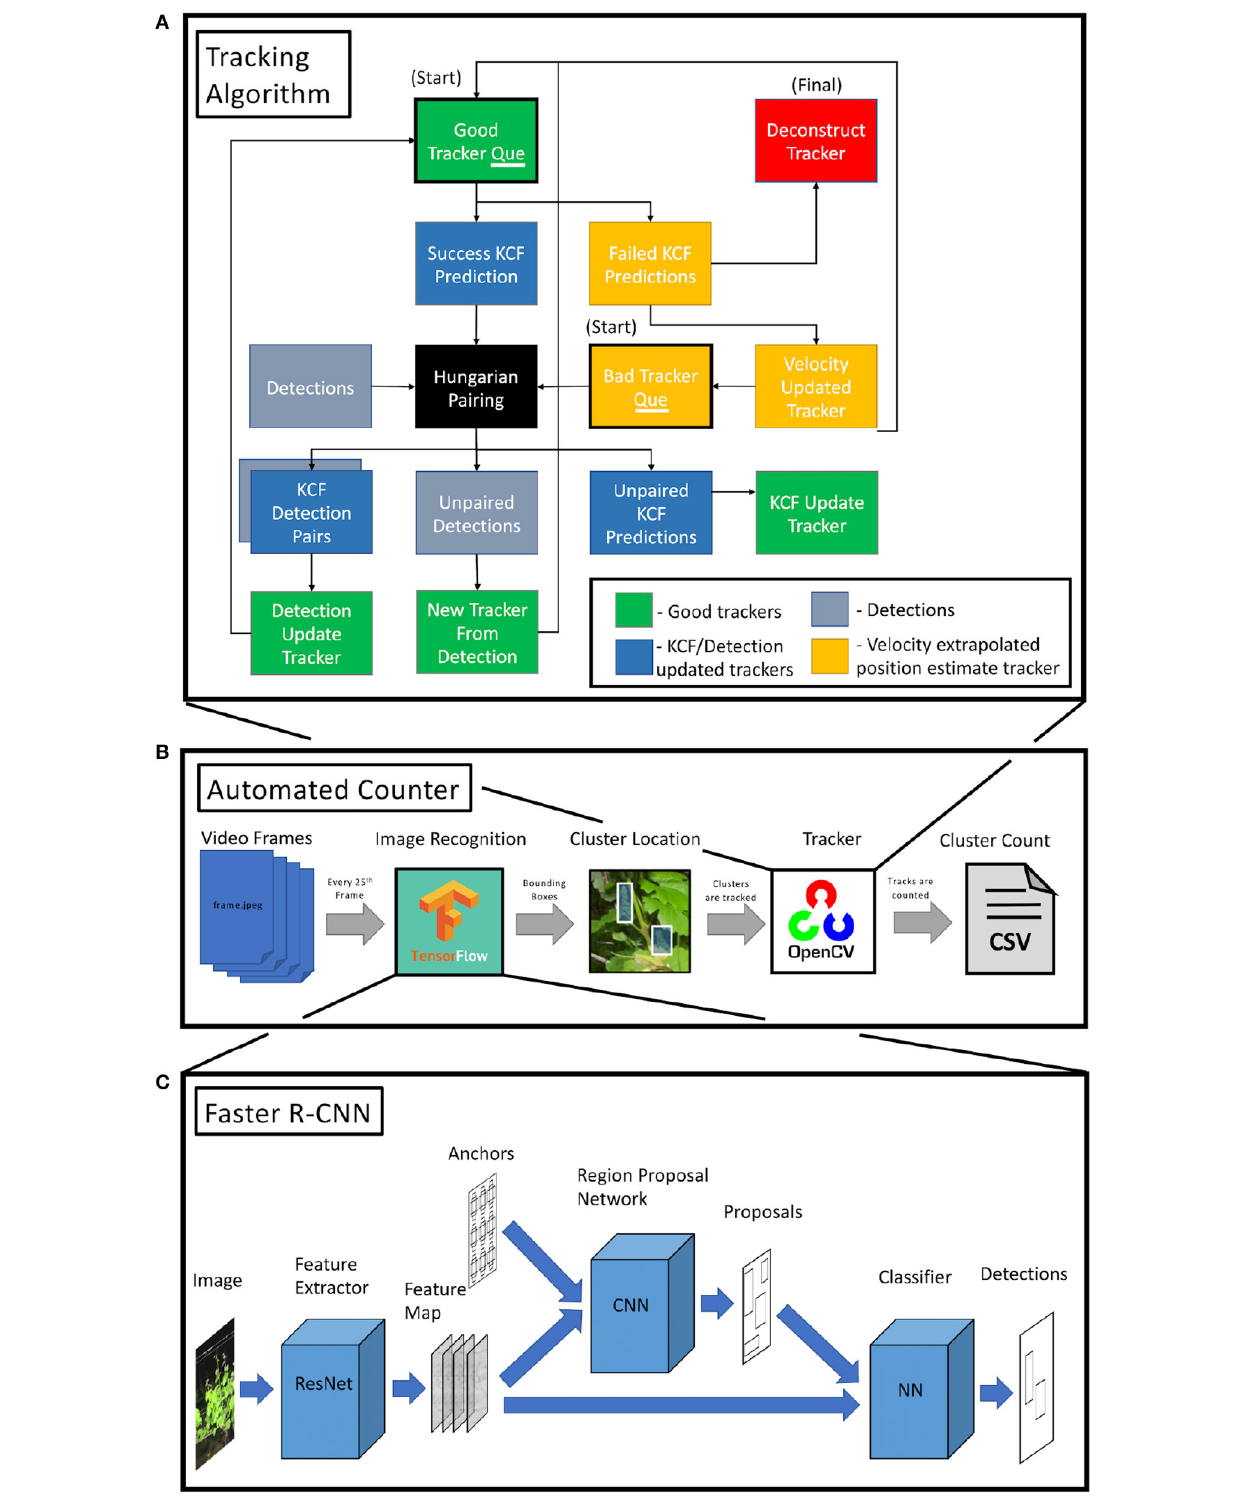
FIGURE 2 | (A) Overview of tracking algorithm used to reduce cluster recounting. Trackers start in one of the two queues (black outline) and are updated using either KCF or, in the event that KCF fails, velocity extrapolation and are then paired with new detections. Unpaired detections are converted into trackers and reenter the queue to be processed in the subsequent frame. (B) System overview of CV software. Video frames are passed into the object detector. These detections are then passed into the tracking algorithm and tallied. (C) Overview of the Faster R-CNN. Three separate networks are used for feature extraction, object location proposal, and